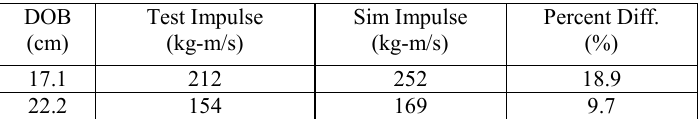
Table 3. LS-DYNA Results